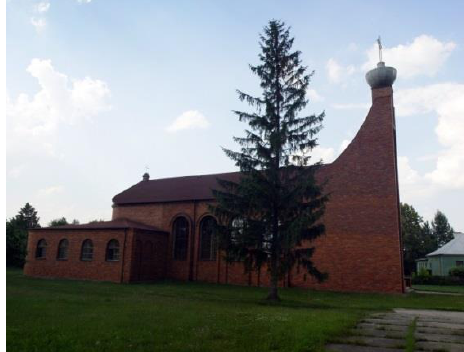
Figure 7. Church of Divine Providence in Krascice (built in 1991–98).